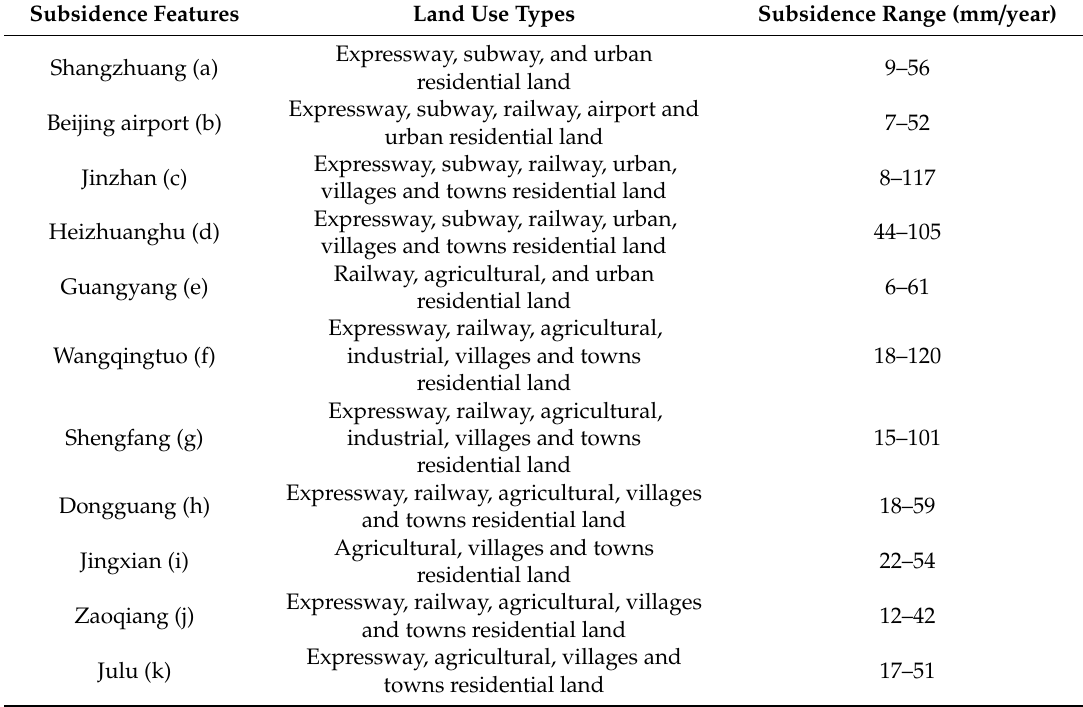
Table 4. Main types of land subsidence in eleven subsidence features areas. The subsidence range represents the range of the average subsidence from 2012 to 2018 in each